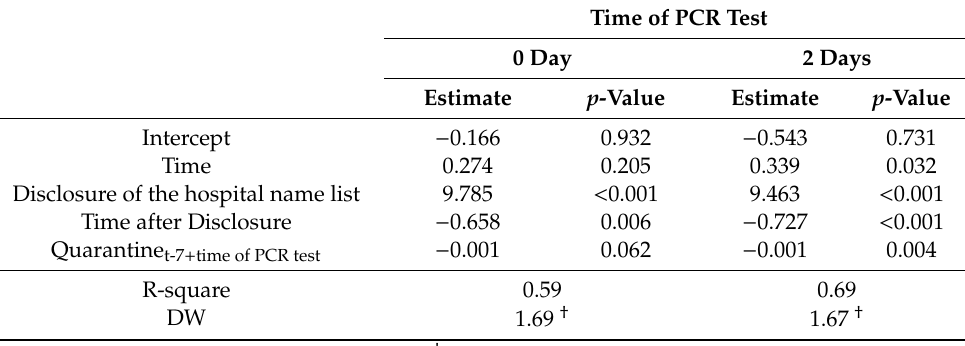
Figure 2. Results of segmented regression for confirmed cases. Table 2. Results of sensitivity analysis of the time taken to complete a PCR